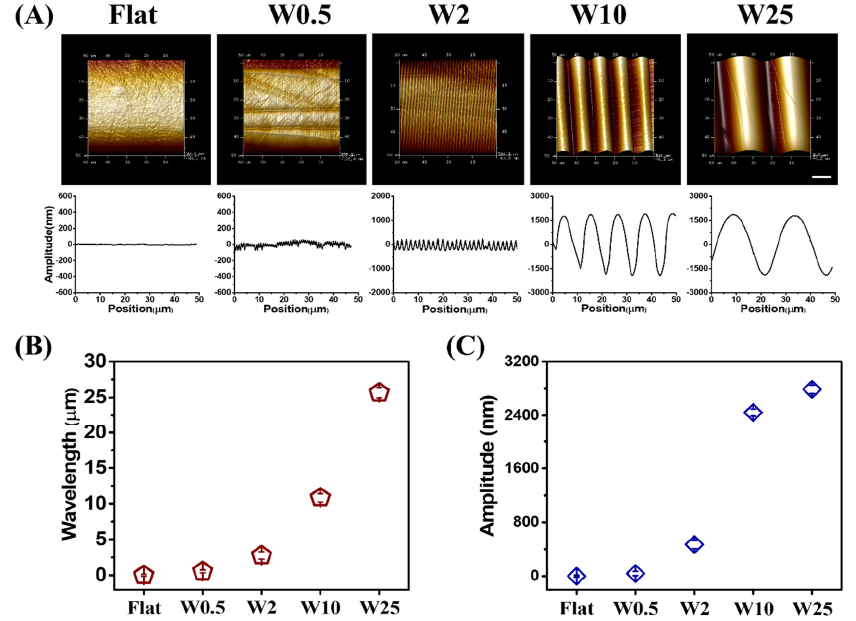
Figure 1. ( A ) AFM images and amplitude curves of the structured PDMS surfaces obtained after imprinting. ( B ) Wavelength and ( C ) Amplitude of created wave-like surface. Data are reported as mean ± standard deviation (SD) ( n = 30 wrinkles). Scale bar is 10 µm and applies to all images.